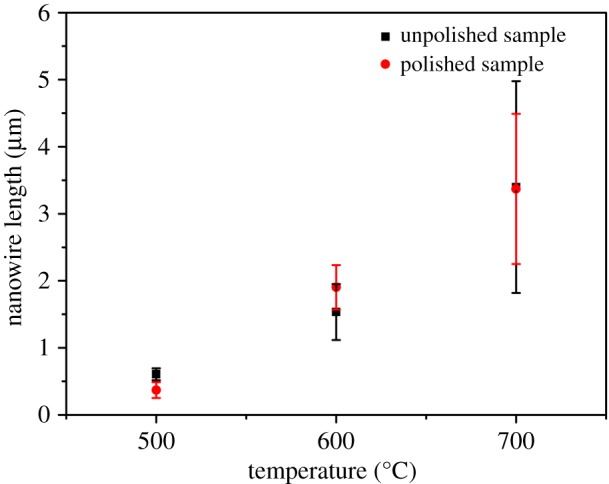
Statistical variation of length of the Fe2O3 nanowires obtained at different experimental conditions.